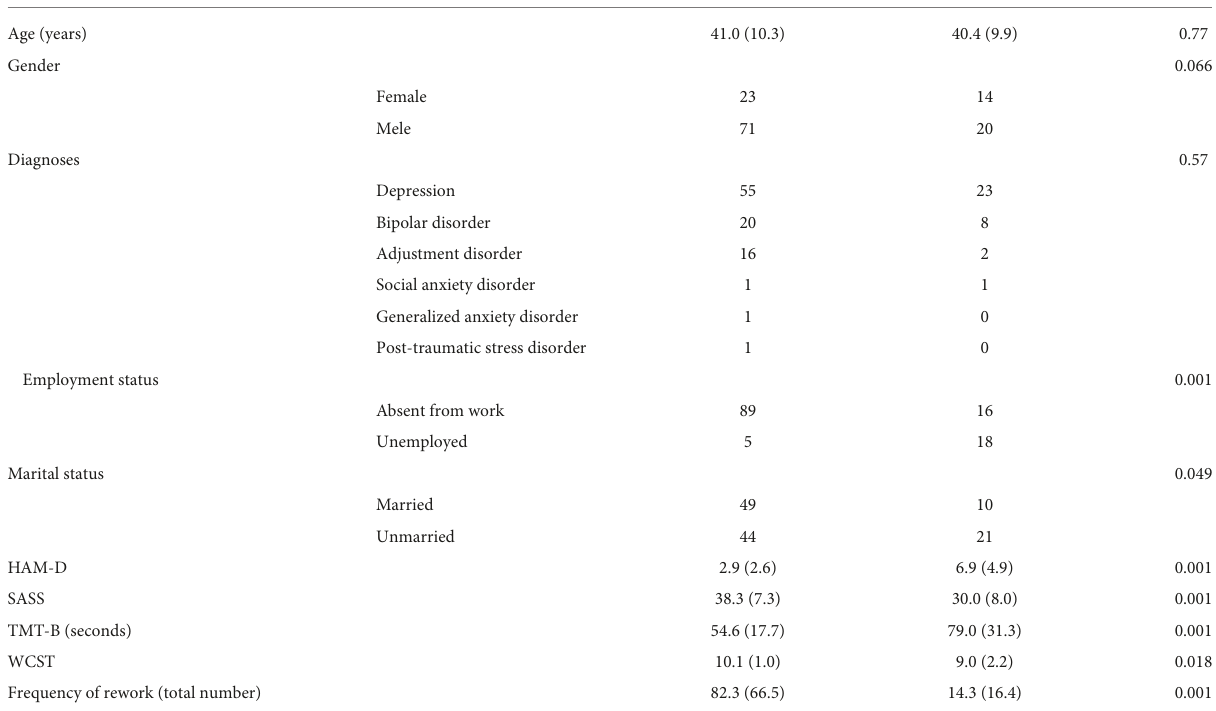
TABLE 2 Comparison of job group and non-job